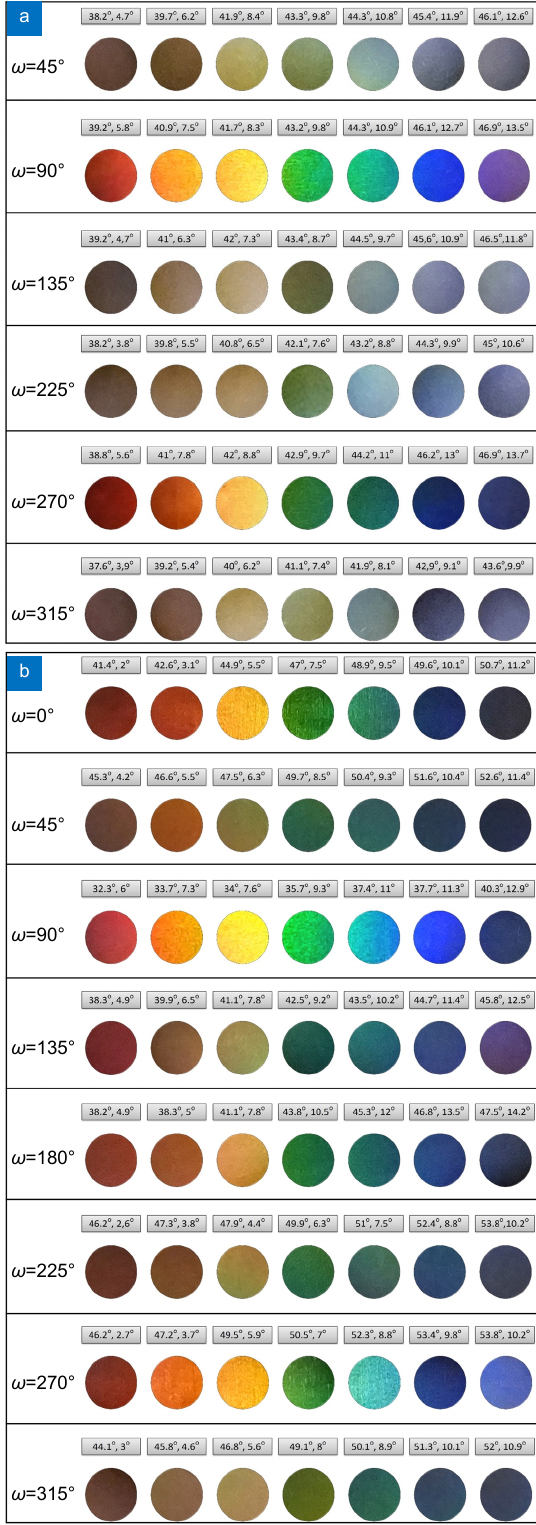
Fig. 6 | ( a ) Diffracted colors of S 1 surfaces obtained upon irradiation with linearly polarized fs beam. ( b ) Diffracted colors of S 2 surfaces obtained upon irradiation with radially polarized fs beam. Each color is characterized by the coordinates ( ω , φ + θ , β ), as defined by the optical system used for their